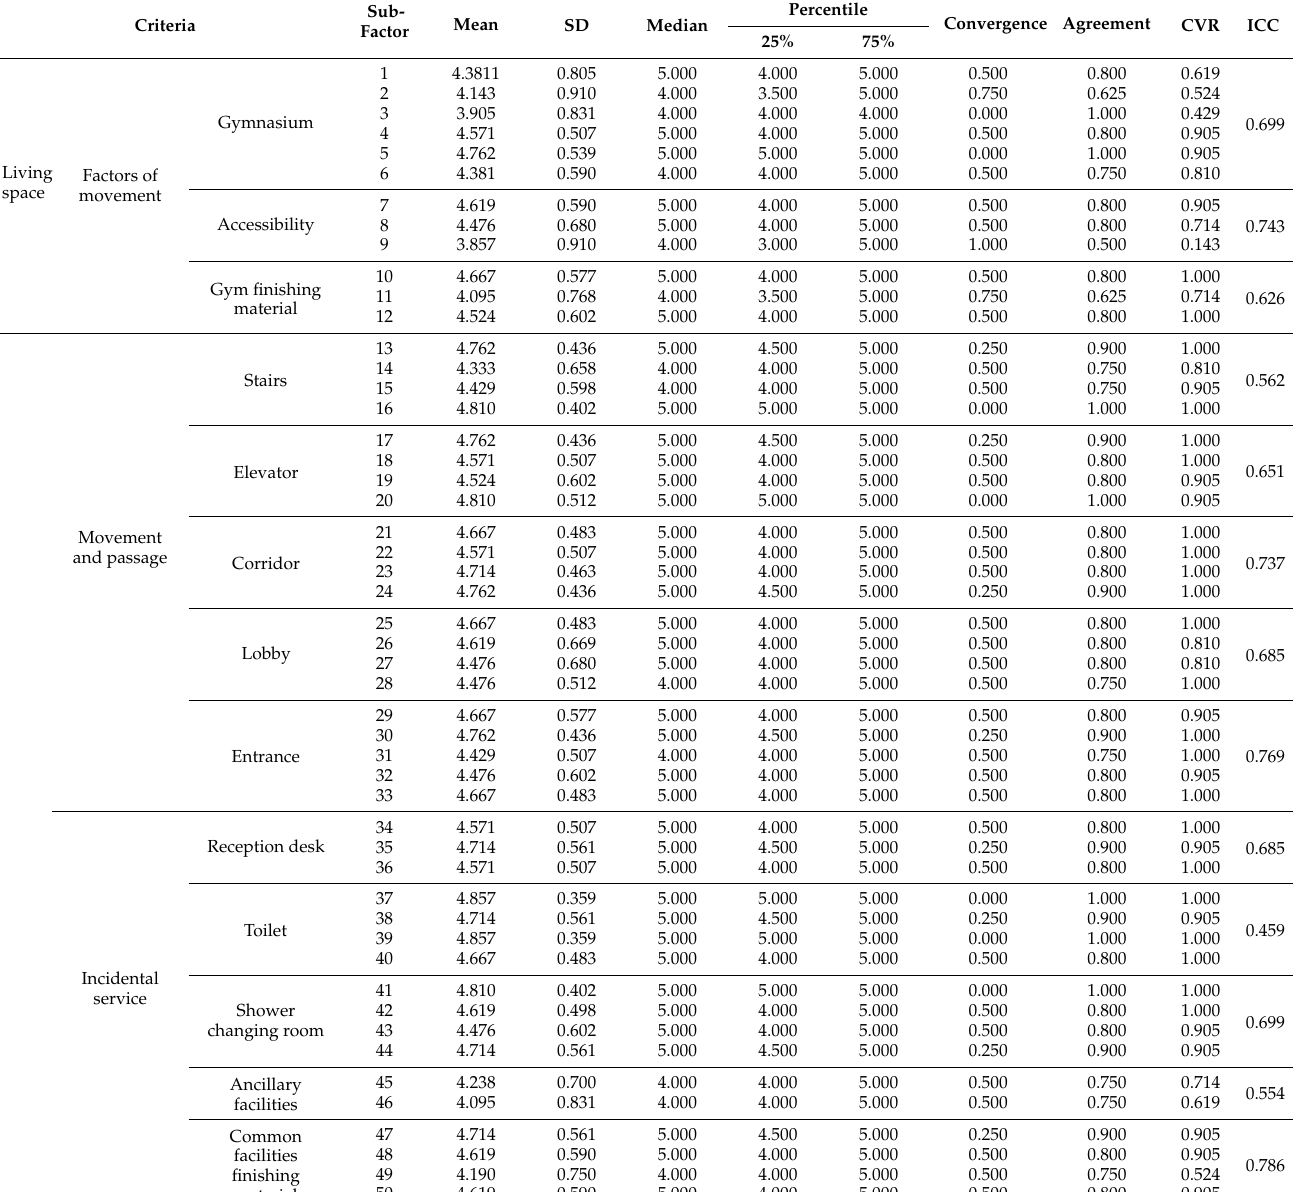
Table 5. Criteria and sub-factors of the Delphi evaluation